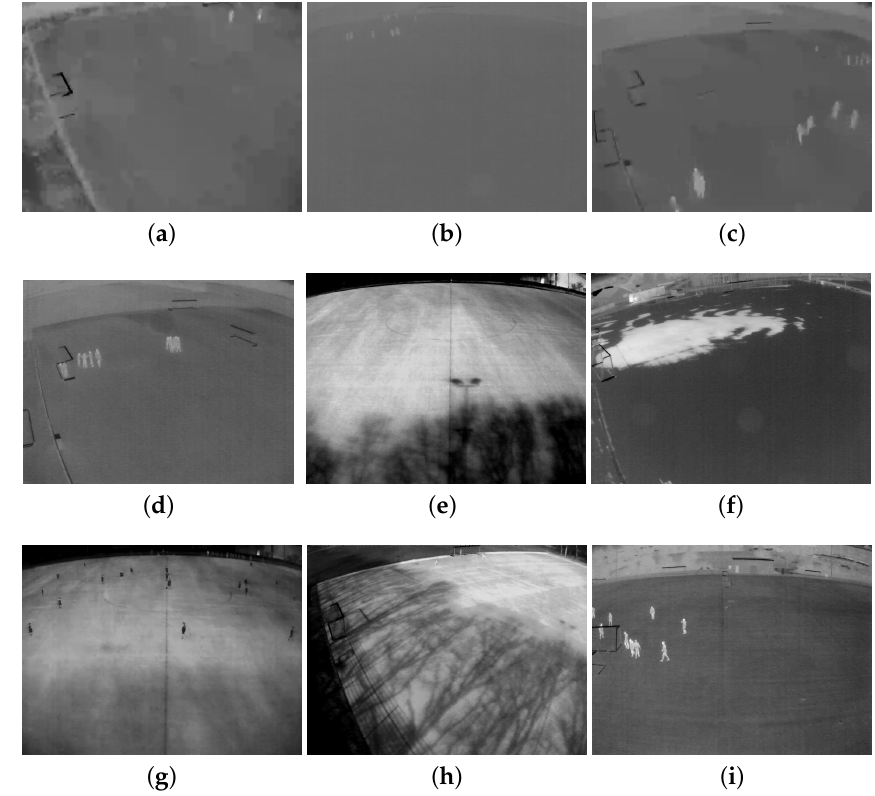
Figure 2. Nine different phenomena that are included in our novel dataset. ( a ) Low resolution. ( b ) Far viewpoint. ( c ) Wind. ( d ). Occlusion. ( e ) Shadow. ( f ) Snow. ( g ) Opposite temperature. ( h ) Similar temperature. ( i ) Good